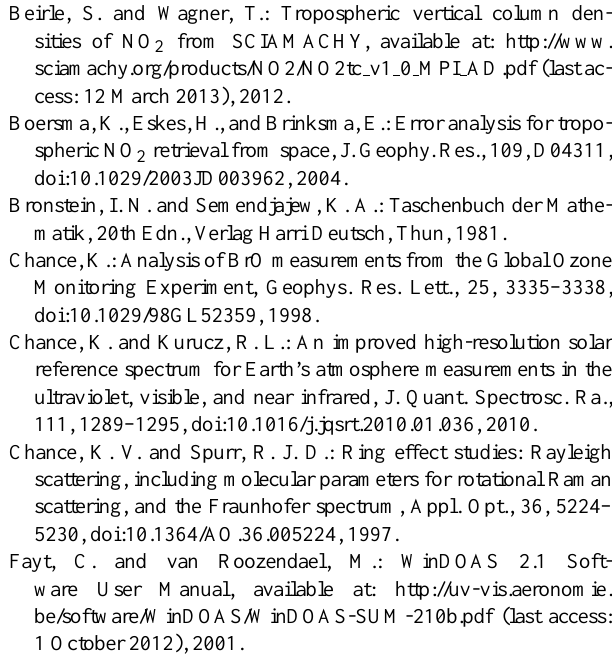
Table 2 lists the respective fit residues and SCD bias of the different derivative definitions for a shift of 0.002 nm.